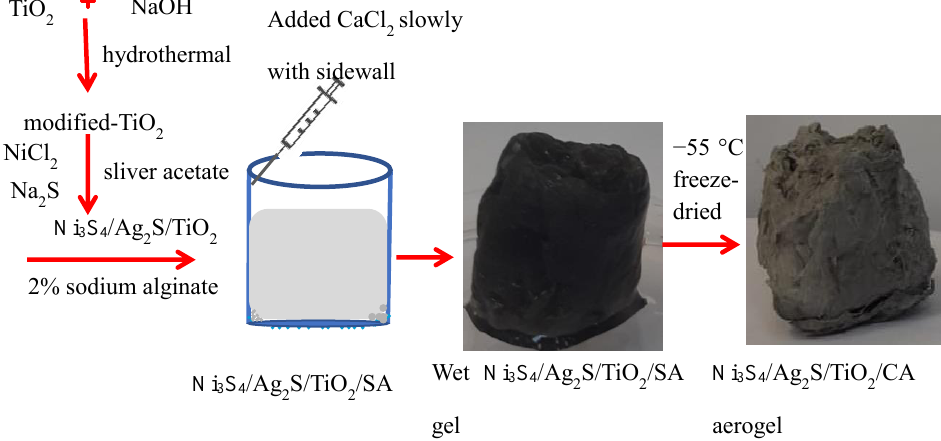
Figure 1. Schematic diagram representing the synthesis of Ni 3 S 4 Ag 2 S/TiO 2 /CA aerogel. The SEM images of Ni 3 S 4 , Ag 2 S and TiO 2 particles can get an idea of their individual sizes (Figure S1). The SEM images of TiO 2 show aggregated clusters of nano-ranged particles. Furthermore, the TEM of TiO 2 shows that nano-ranged particles (<100 nm) are aggregated into clusters of ~500 nm size. The SEM of Ag 2 S shows the majority of particles of sizes in the range of 20–100 nm along with the observance of small clusters of particles with even larger sizes. The SEM of Ni 3 S 4 shows interconnected globules of micrometer size; however, small clusters of loosely packed particles (approximately in the nanometers range) can be seen protruding out of the